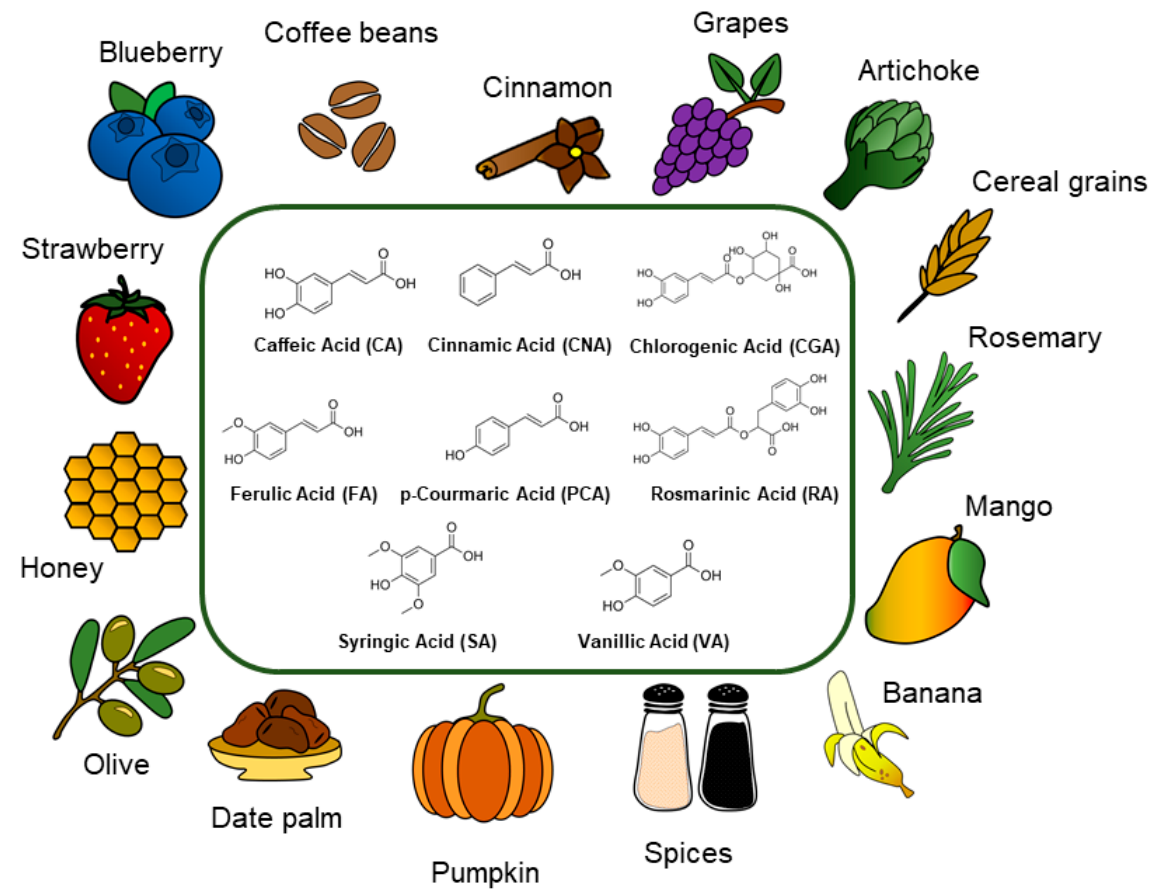
Figure 1. Schematic representation of the phenolic acids’ structures and their main source.